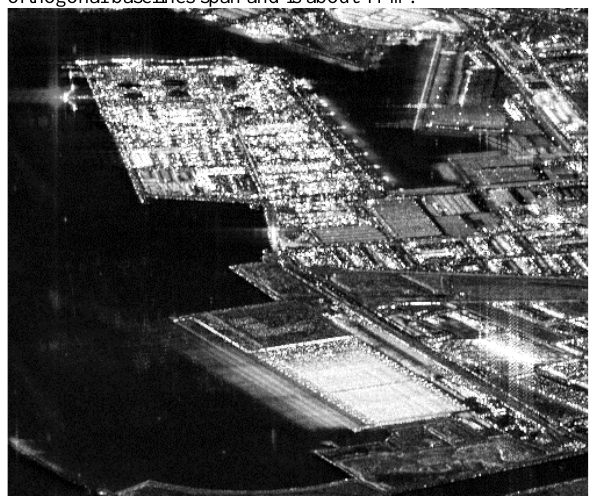
Figure 1. Sentinel-1 amplitude image of the test